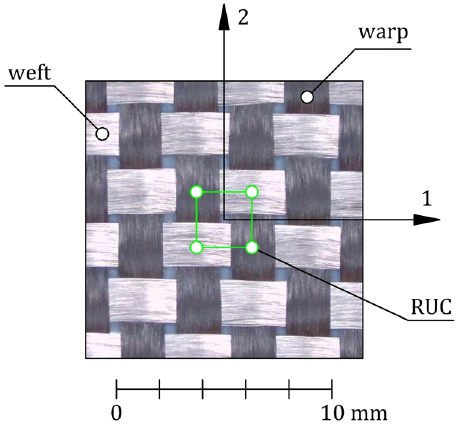
Figure 2: Architecture of the selected plain weave carbon roving fabric.